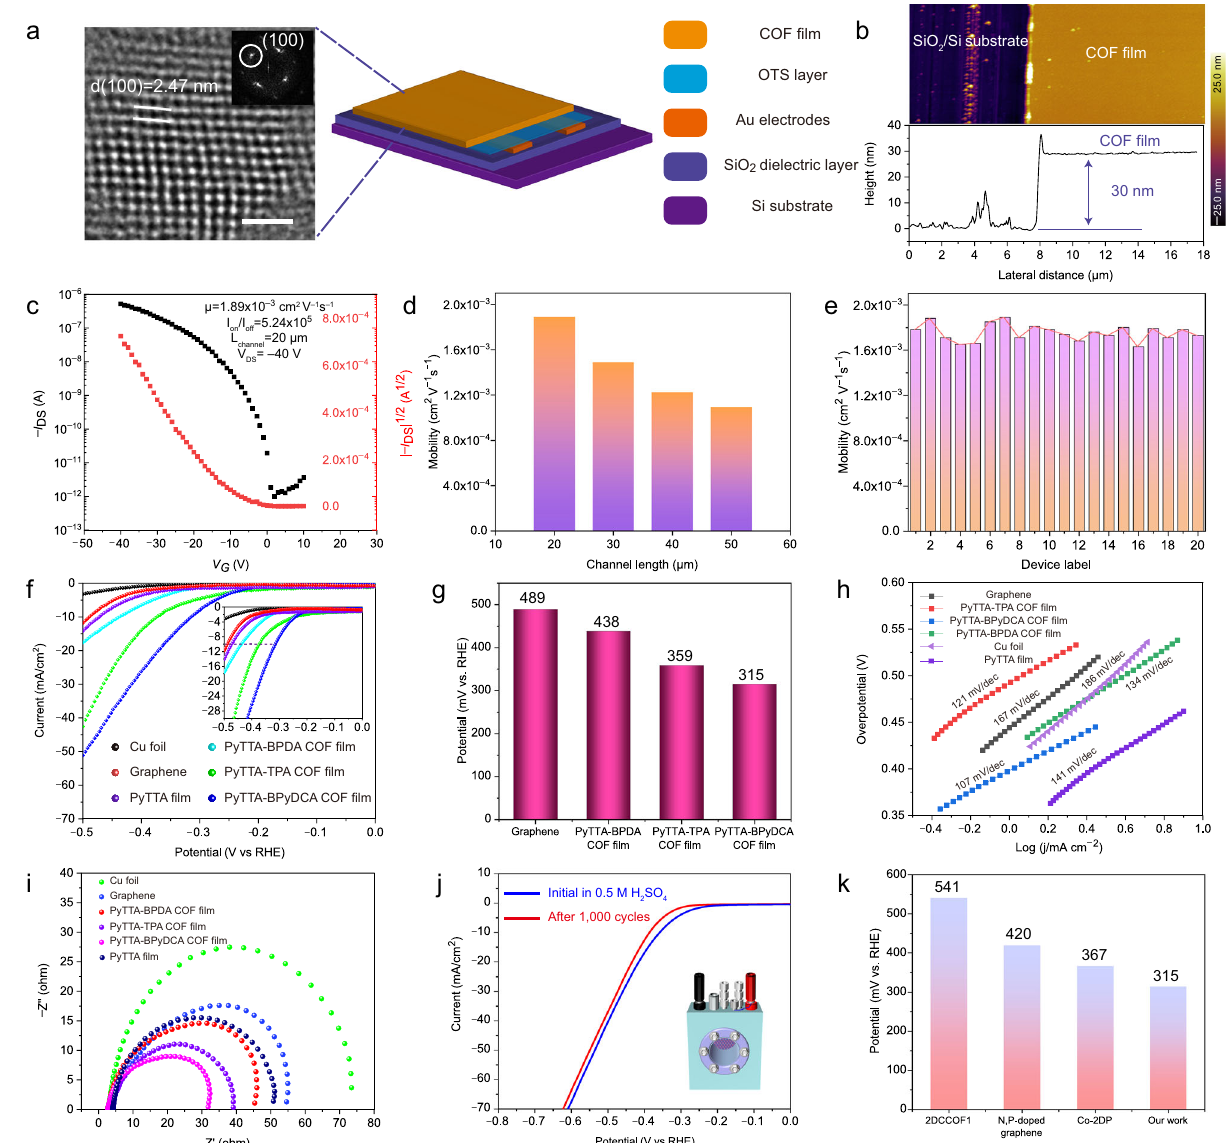
Fig. 5 Electrical properties of COF fi lms. a Schematic diagram of a FET device using PyTTA-TPA fi lm as working materials. Scale bar 10 nm. b AFM image of the PyTTA-TPA COF fi lm used for FETs with a thickness of ~30 nm. Scale bar 4 μ m. c Transfer characteristics ( I DS vs V G ) of the PyTTA-TPA COF device at V DS = − 40 V. d Hole mobility of the PyTTA-TPA COF-based FET devices under different channel lengths. e Distribution histogram of hole mobility. f LSV curves of Cu foil, graphene, PyTTA-TPA, PyTTA-BPyDCA, and PyTTA-BPDA COF fi lms in 0.5 M H 2 SO 4 . g Overpotential of graphene, PyTTA-TPA, PyTTA-BPyDCA, and PyTTA-BPDA COF fi lms at current density of 10 mA cm − 2 . h Tafel plots of Cu foil, graphene, PyTTA-TPA, PyTTA-BPyDCA, and PyTTA-BPDA COF fi lms. i Nyquist plots of Cu foil, graphene, PyTTA-TPA, PyTTA-BPyDCA, and PyTTA-BPDA COF fi lms. j LSV plots of PyTTA-TPA COF fi lm before and after 1000 CV cycles. k Compared with reported materials 54,55,57